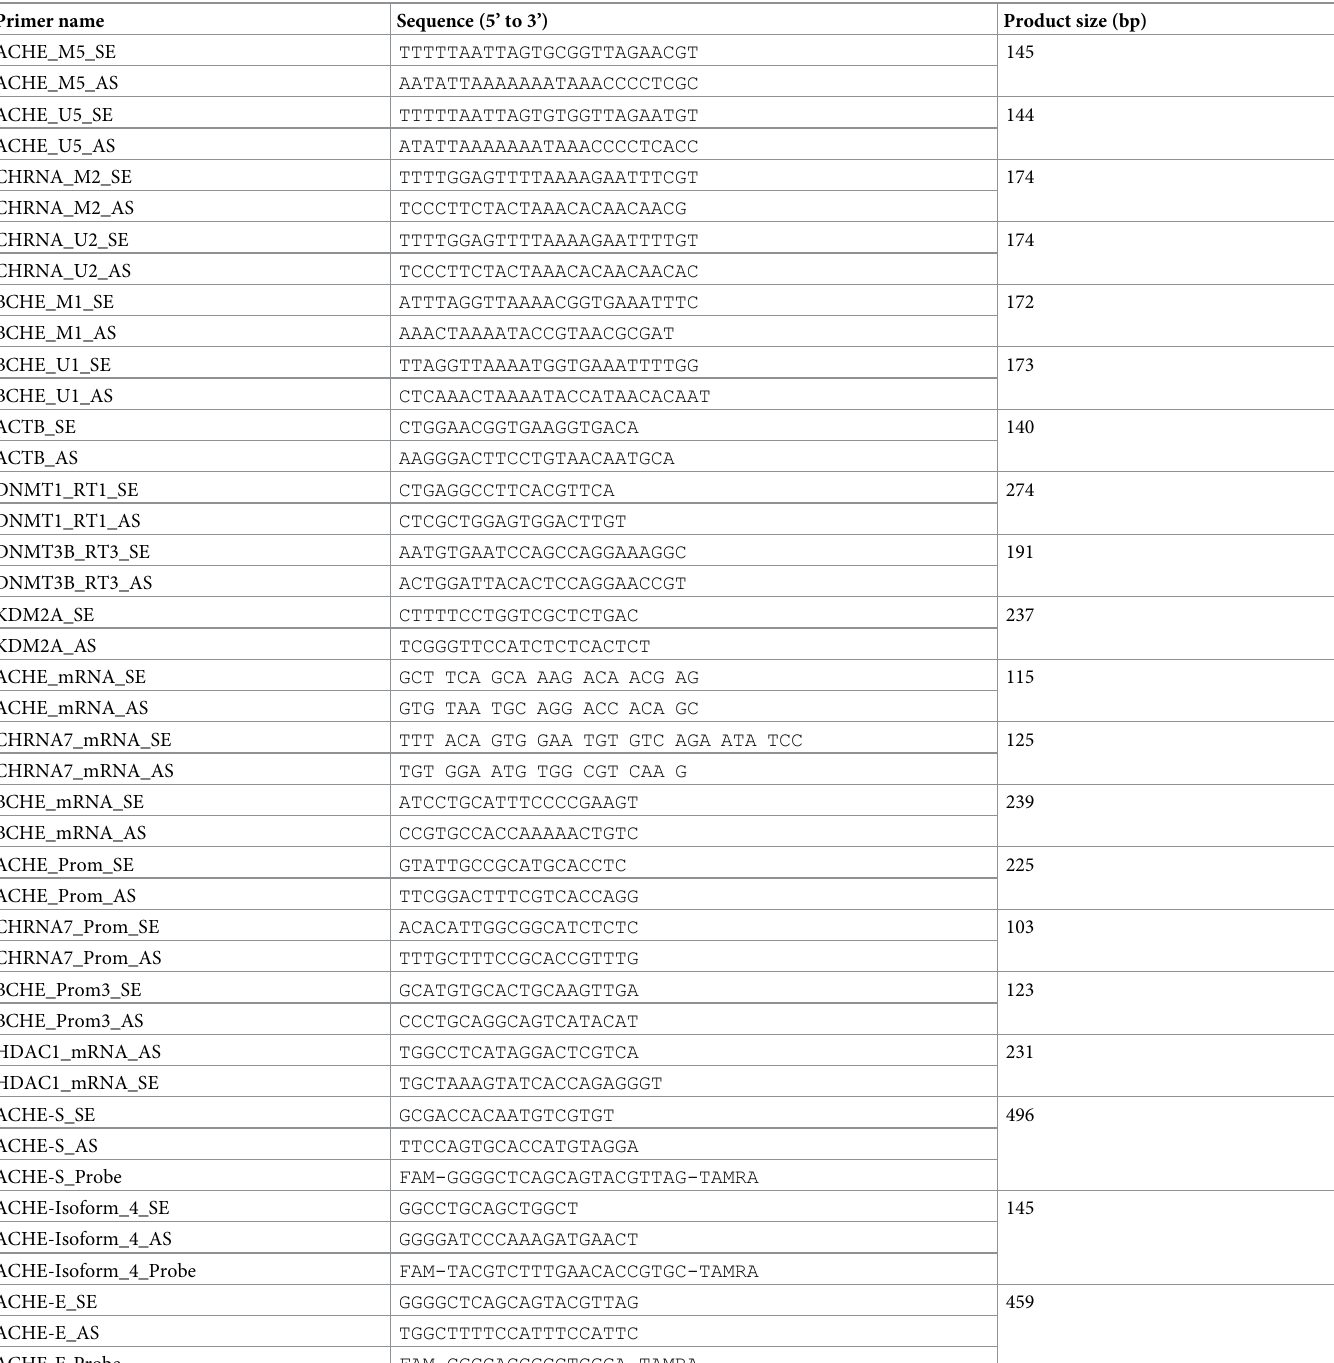
Table 1. Primer pairs for quantitative real-time